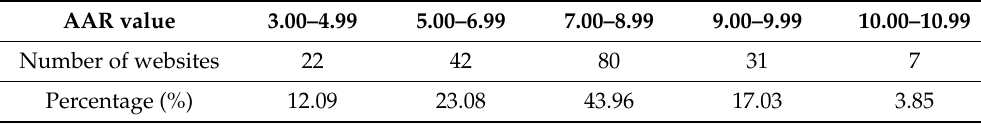
Table 5. Number of websites by the AAR